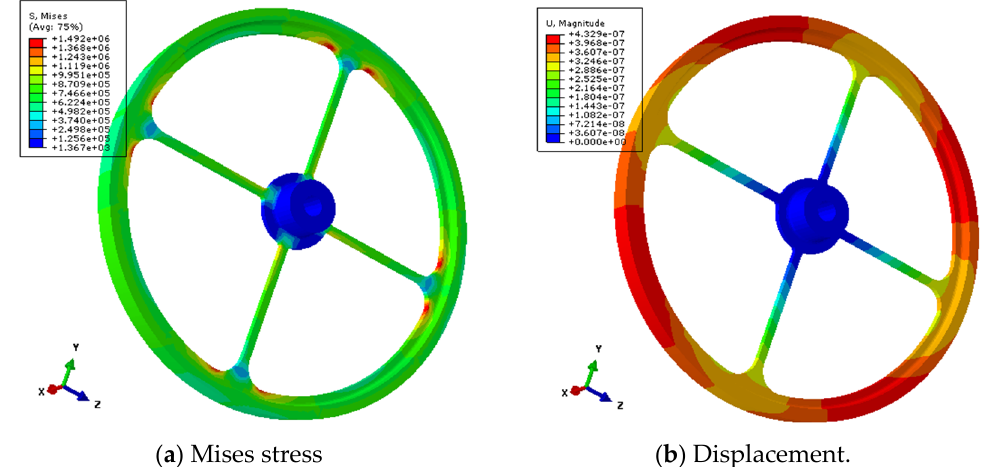
Figure 10. Optimal solution of the finite element simulation.